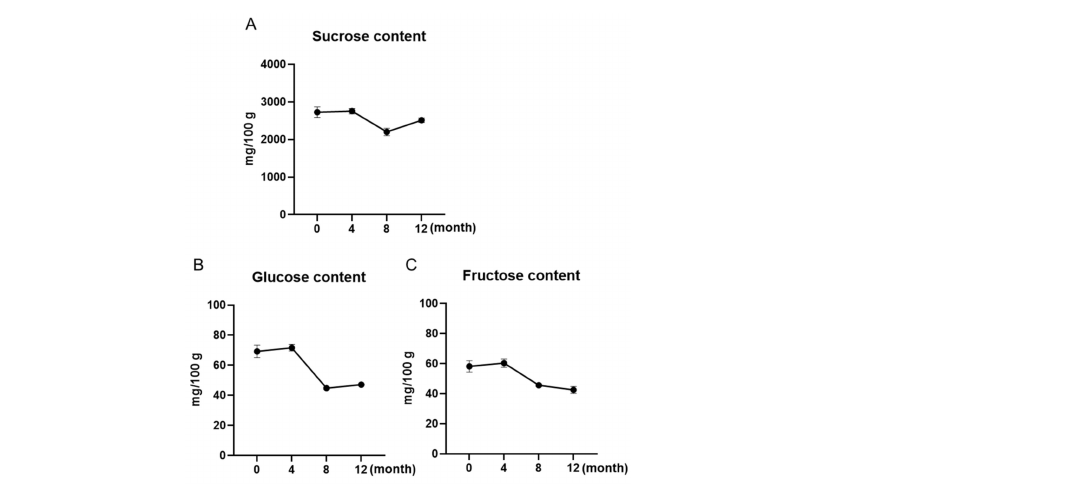
Figure 2. Changes in maple water carbohydrate content including sucrose ( A ), glucose ( B ), and fructose ( C ) during a storage time of 12 months at room temperature. Each sample was measured at time points of 0, 4, 8, and 12 months.